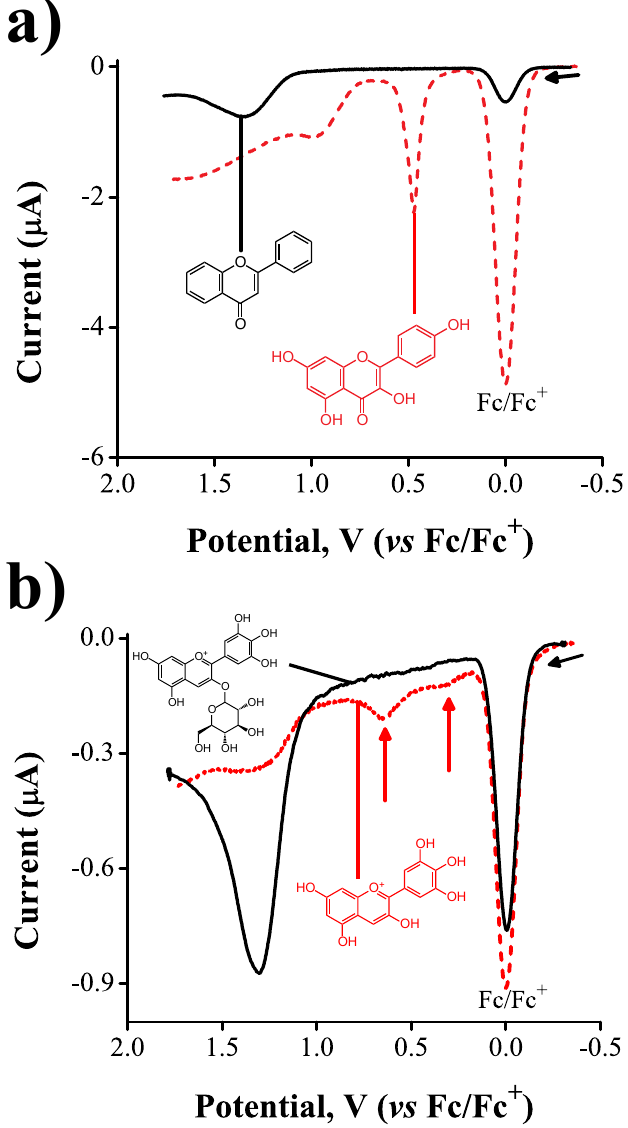
Figure 2. ( a ) square wave voltammograms ( Ψ vs. E ) of 0.5mM flavone + 0.1mM ferrocene + 0.1M tetraethyammonium tetrafluoroborate, TEATFB (solid line) and 2.5mM kaempferol + 0.5mM ferrocene + 0.1M TEATFB (dashed line); and ( b ) square wave voltammograms of 0.5mM delphinidin-3 O -glucoside + 0.09mM ferrocene + 0.1M TEATFB (solid line) and 0.1mM delphinidin + 0.11mM ferrocene + 0.1M TEATFB (dashed line). In all experiments ∆ E = 50mV, f =